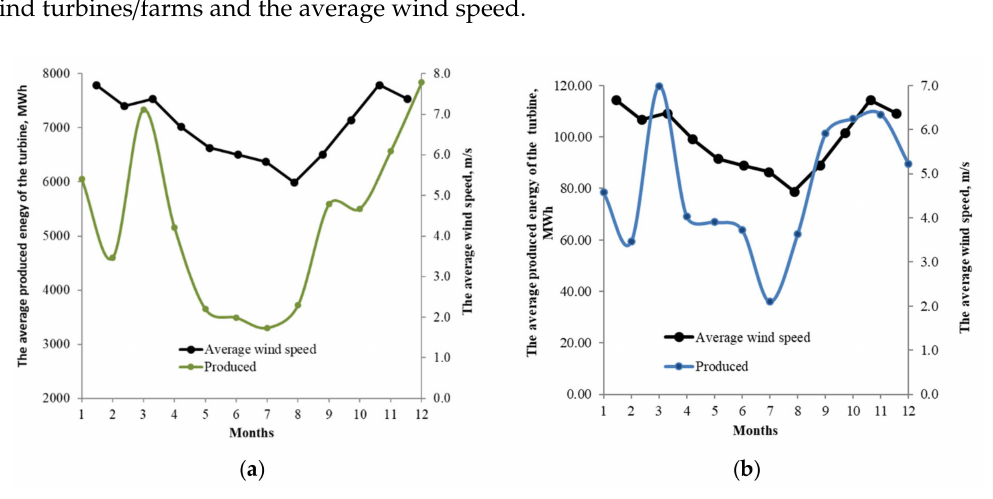
Figure 7. Relationship between the average produced energy by wind turbines / farms and the average wind speed: ( a ) in > 10 MW capacity of the wind turbines; ( b ) in < 10 MW capacity of the wind